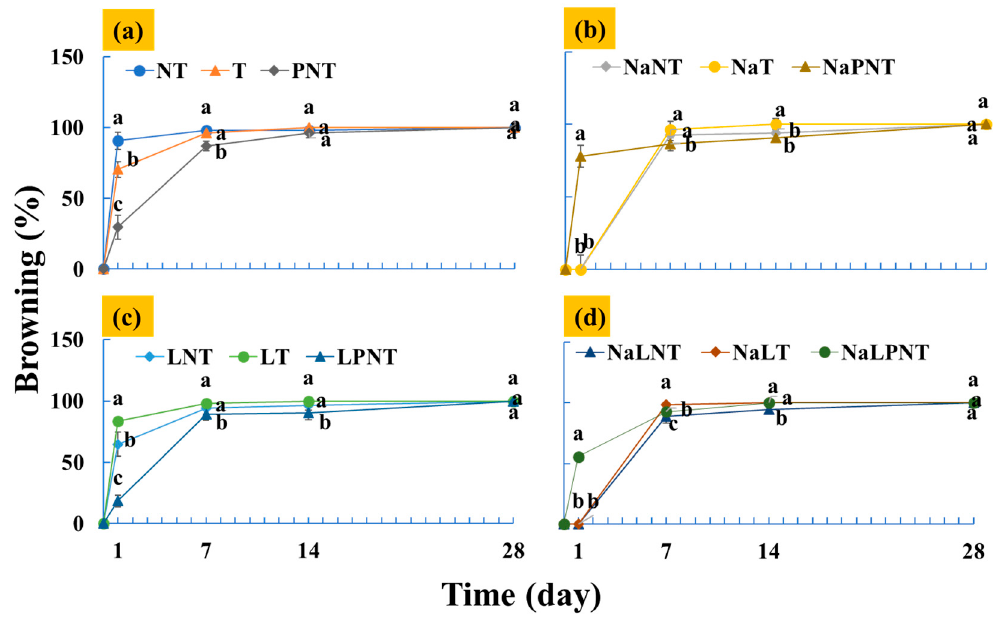
Figure 1. Browning percentage of the petal explants of herbaceous peony ‘Festival Maxima’. The different abbreviations denote as follows: Na, dipping in a 0.5 g·L -1 NaCl solution before planting; P, 0.5 g·L -1 polyvinyl pyrrolidone (PVP) addition to the medium; L, storage at 4 ℃ for 24 h after planting; NT, not transferring to a new medium; and T, transferring to a new medium at 24 h after planting. Treatments were set into 4 groups; ( a ), NT, T, and PNT; ( b ), NaNT, NaT, and NaPNT; ( c ), LNT, LT, and LPNT; and ( d ), NaLNT, NaLT, and NaLPNT. Different alphabet letters indicate differences